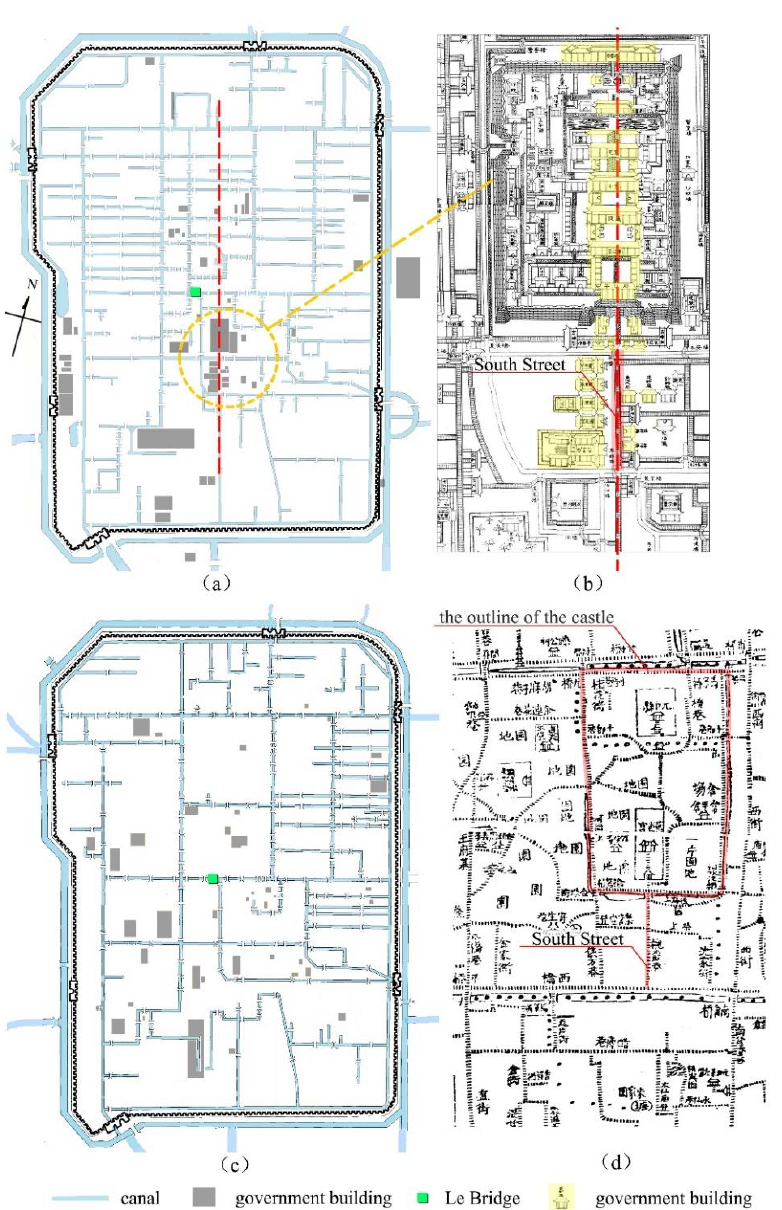
Figure 6. The castle and its axis. ( a ) government buildings in Map of Pingjiang . ( b ) the castle and the axis. ( c ) government buildings in Map of Gusu City . ( d ) the fragmentized of the castle.